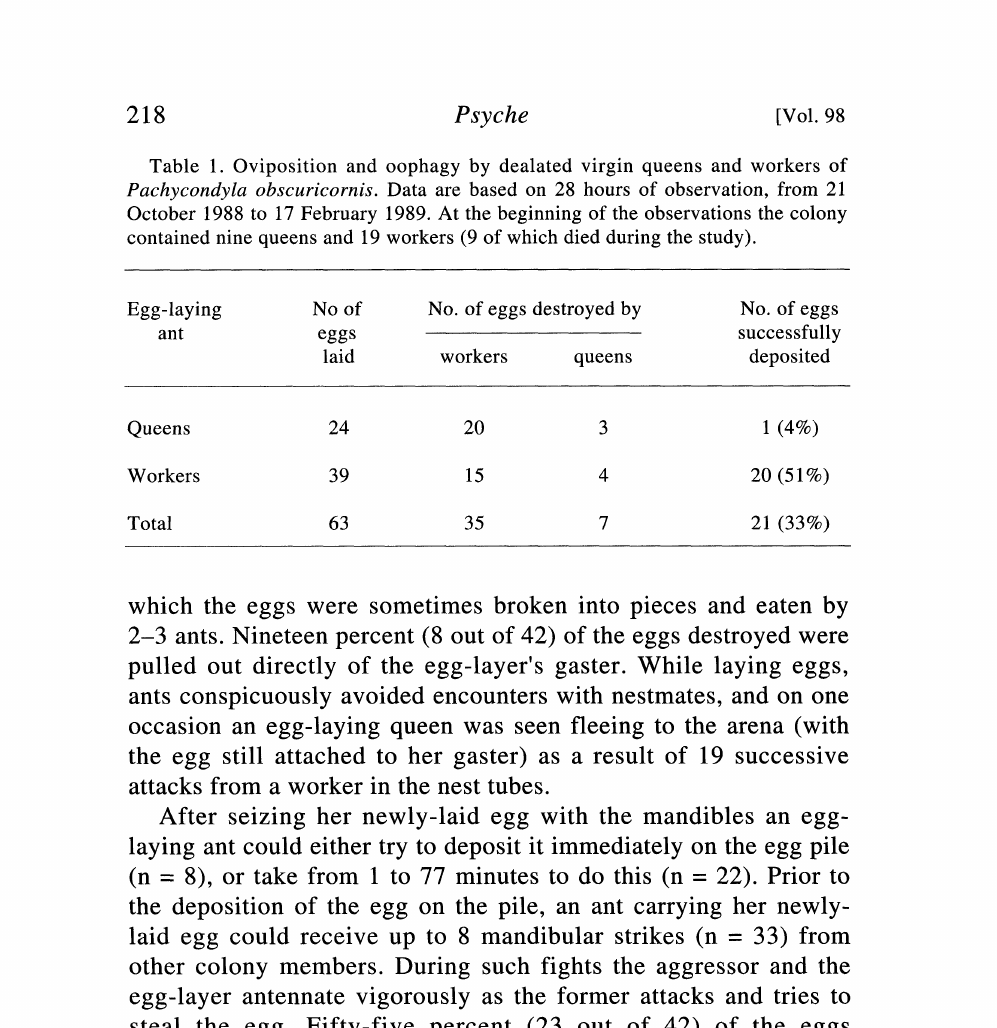
Table 1. Oviposition and oophagy by dealated virgin queens and workers of Pachycondyla obscuricornis. Data are based on 28 hours of observation, from 21 October 1988 to 17 February 1989. At the beginning of the observations the colony contained nine queens and 19 workers (9 of which died during the